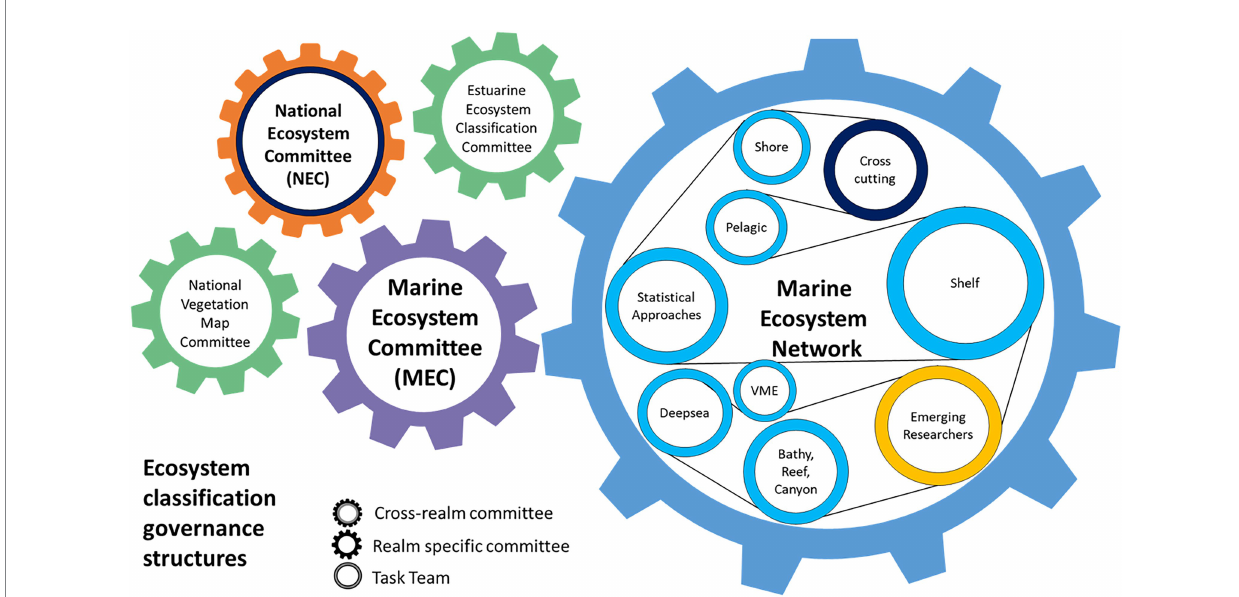
FIGURE 3 Ecosystem classification governance structures pertinent to the marine realm in South Africa. Marine ecosystem classification and mapping is led by a Marine Ecosystem Committee guided by a cross-realm National Ecosystem Committee (orange) but supported by other coastal committees (green) and the marine ecosystem network that includes nine task teams, seven of which are thematic (blue), one cross-cutting (black), and one dedicated to emerging researchers (yellow). VME refers to Vulnerable Marine